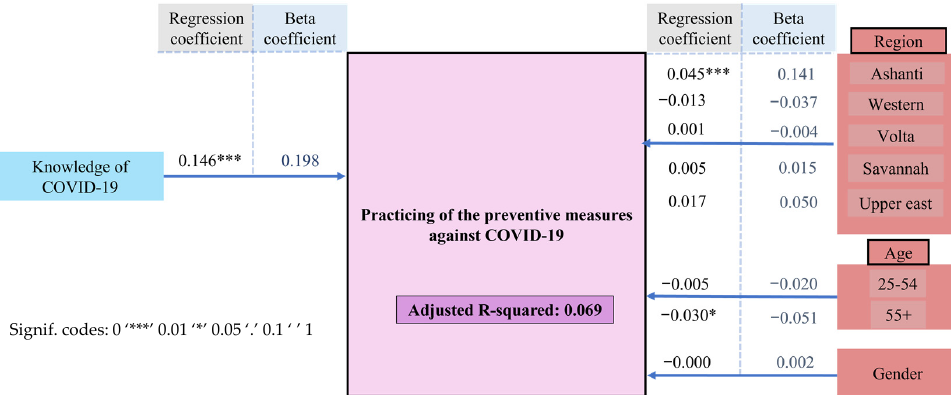
Figure 5. The practices against COVID-19 model employed to assess the influences of knowledge related to COVID-19 and the practicing of preventive measures recommended by the WHO. The results are shown in terms of regression coefficient estimates and beta coefficients.